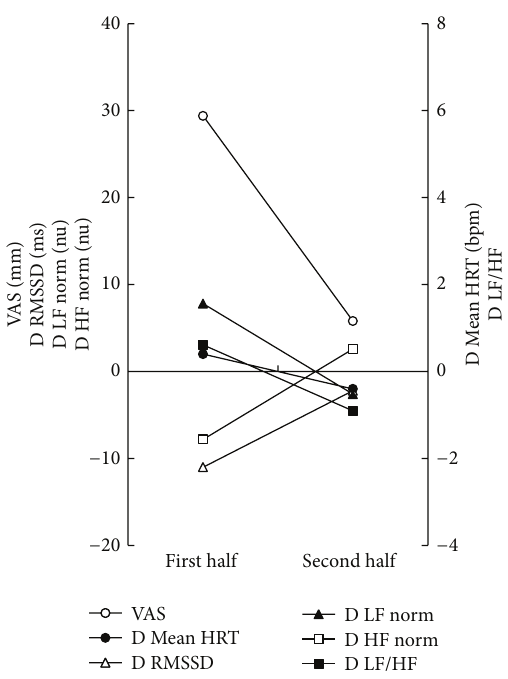
Figure 1: Time course of differential frequency-/time-domain parameters during SGR in case